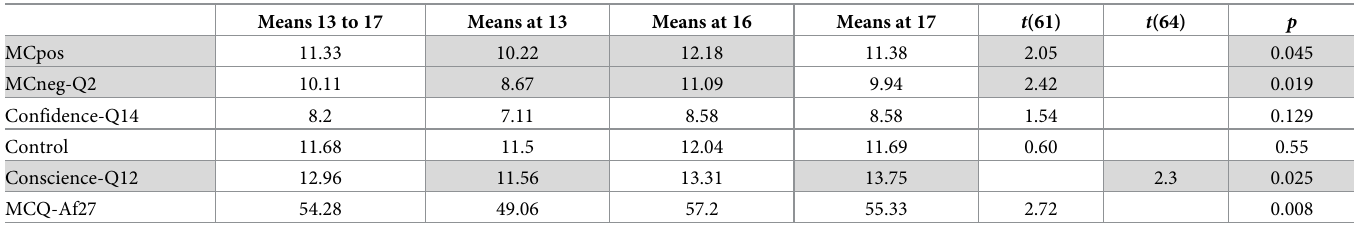
Table 5. Means of the 5 factors of the MCQ-Af27 between age 13 and 17, N = 214. Means 13 to 17